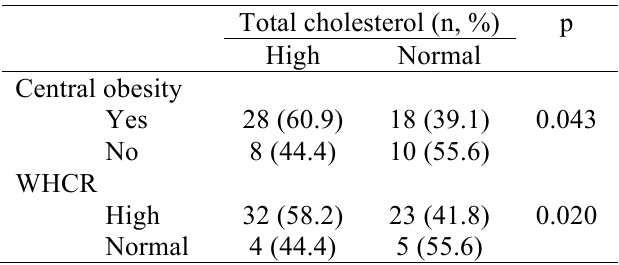
Table 3a Association between central obesity and WHCR to total cholesterol (n=64)